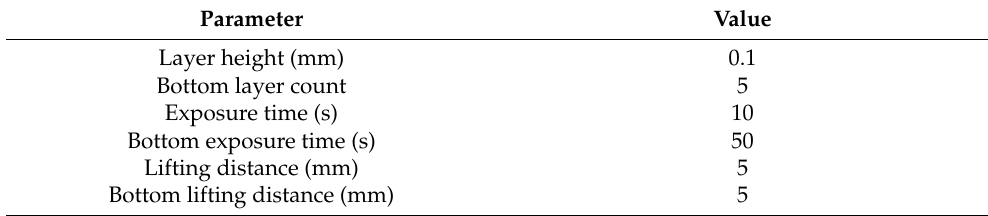
Table 1. Printing parameters of the resin 3D JAKE in the Elegoo Mars